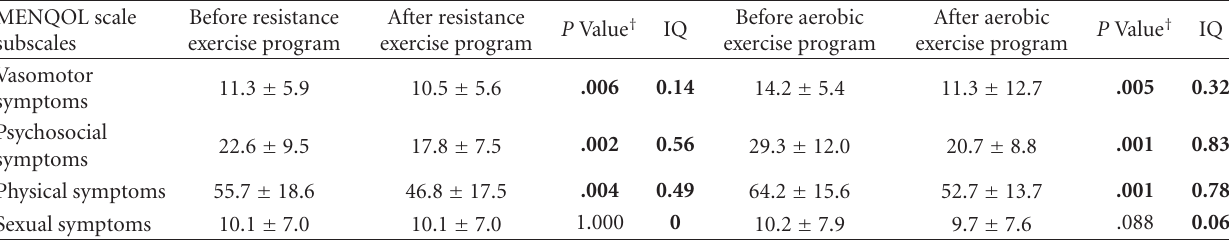
Table 5: MENQOL scale subscale points of Aerobic and Resistance exercise groups before and after the exercise program X ± SD, N = 18. MENQOL scale subscales